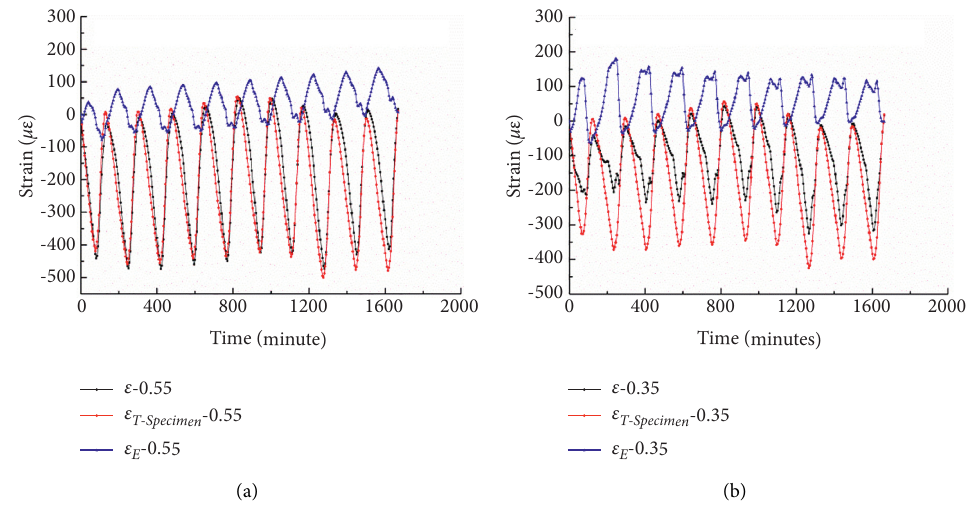
Figure 8: Strain behaviors before and after temperature compensation. (a) W/C � 0.55. (b) W/C � 0.35.